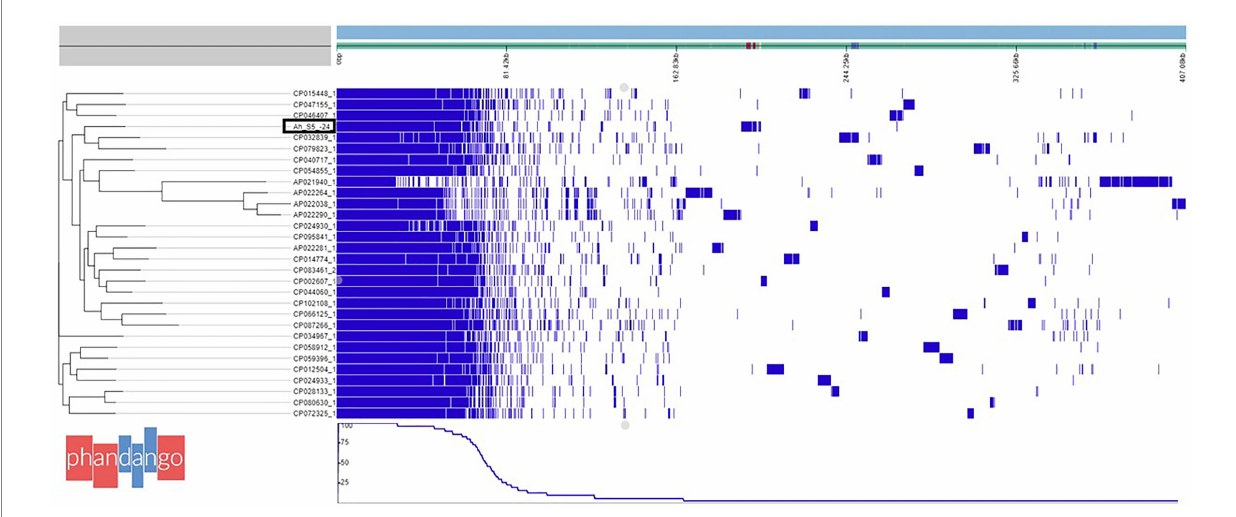
FIGURE 1 Phylogenetic tree based on pangenome analysis of Aeromonas veronii AhS5-24 together with 30 complete genomes of other A. veronii strains obtained from the National Center for Biotechnology and Information (NCBI). Note that A. veronii AhS5-24 is clustered together with A. veronii strains FC951 (CP032839) isolated from hospital sewage. A total of 20352 genes were detected in all 31 A. veronii genomes by pangenome analysis using the Roary software of which 1,429 genes were core genes, 875 soft core genes while the number of shell and cloud genes was 2,241 and 15,807 genes,